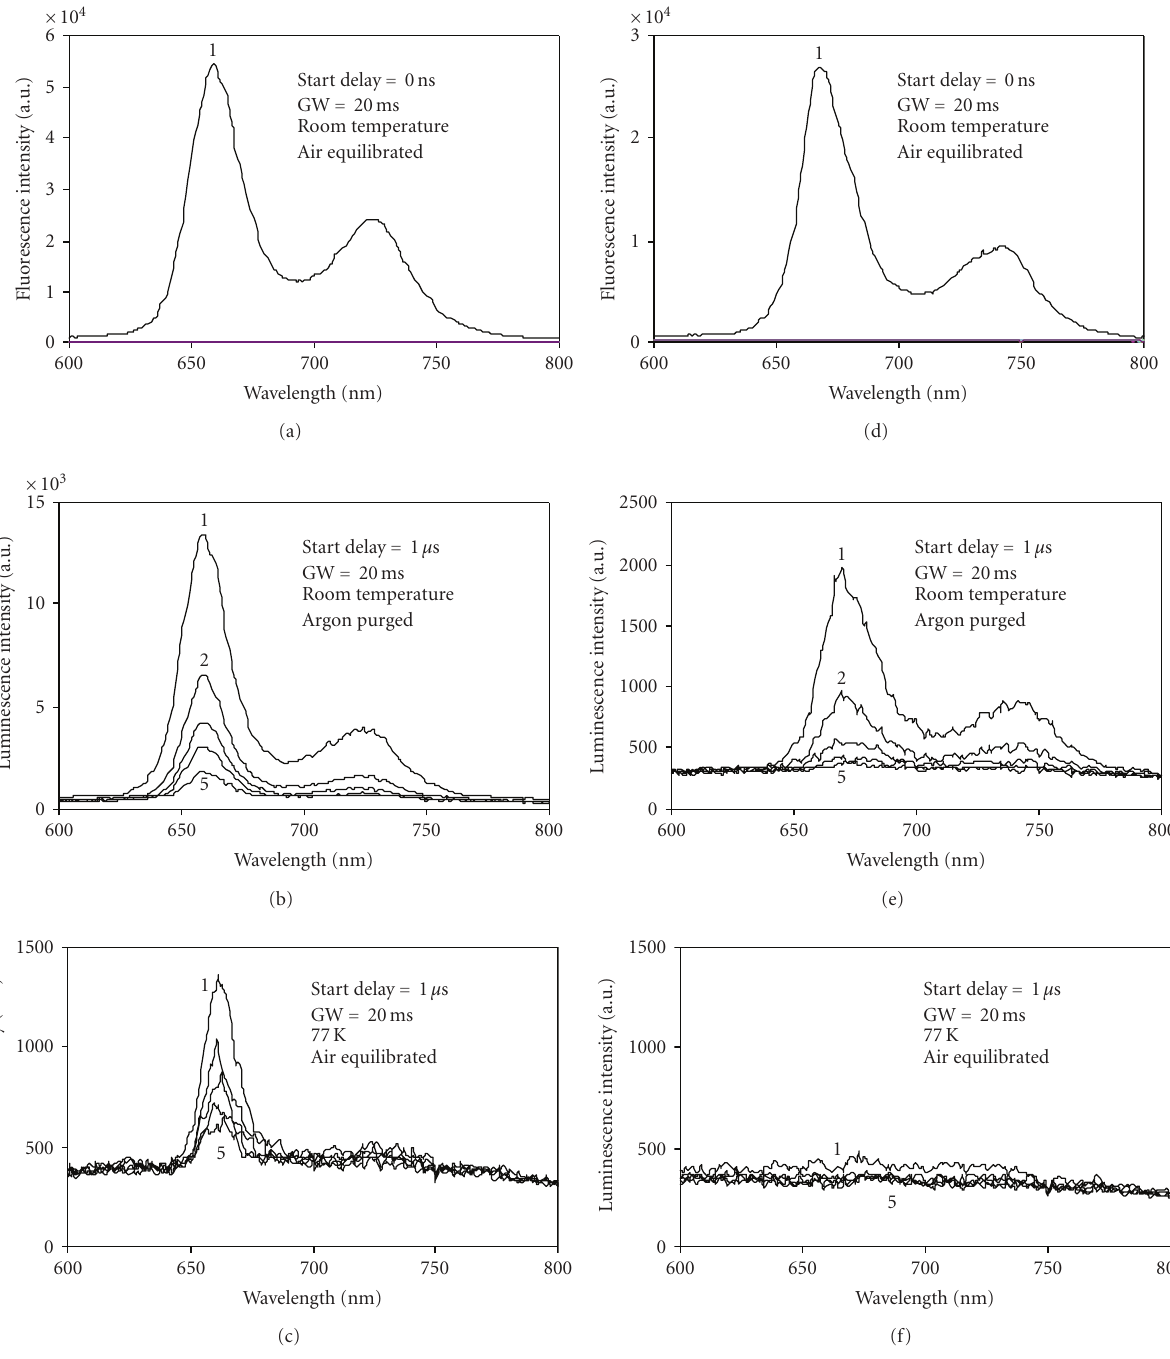
Figure 5: Time-resolved laser-induced luminescence emission spectra of TPP (left column) and TBP (right column) in benzene. Spectra were registered with a 20ms gate with at (a), (d) room temperature, in presence of O 2 (air equilibrated samples), (b), (e) room temperature, in absence of O 2 (argon purged samples), (c), (f) T = 77 K, in presence of O 2 (air equilibrated samples), (50, 100, 150, 200 and 250 μ s, after laser pulse, resp., for curves 1 to 5 at 337 nm). The start delay was zero in (a) and (d) and 1 μ s in (b), (c), (e), and